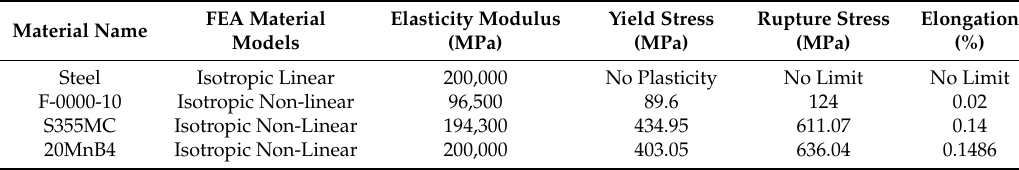
Table 1. Material properties for finite element analysis